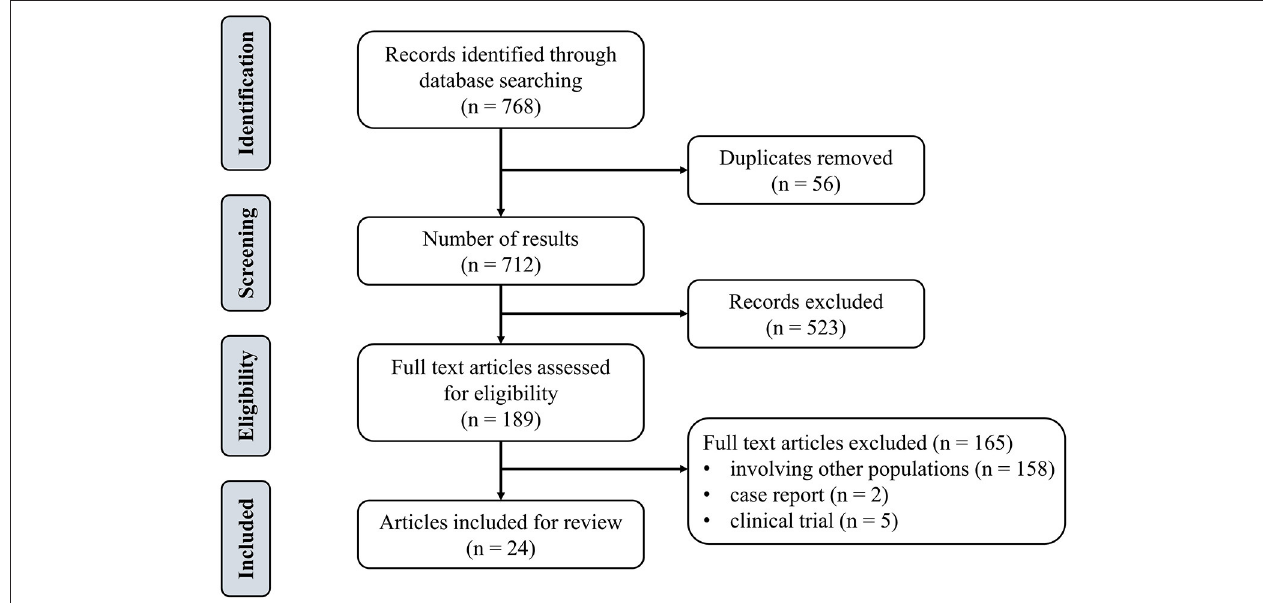
FIGURE 1 | Flowchart of the search and inclusion